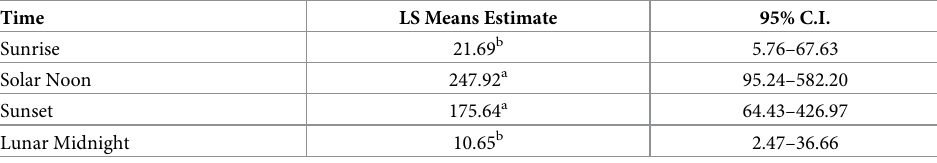
Table 4. Least square means with confidence intervals for New Jersey bottle rotator trap counts of all Aedes albo- pictus at two study sites over three seasons (early, peak and late) combined, during four different time